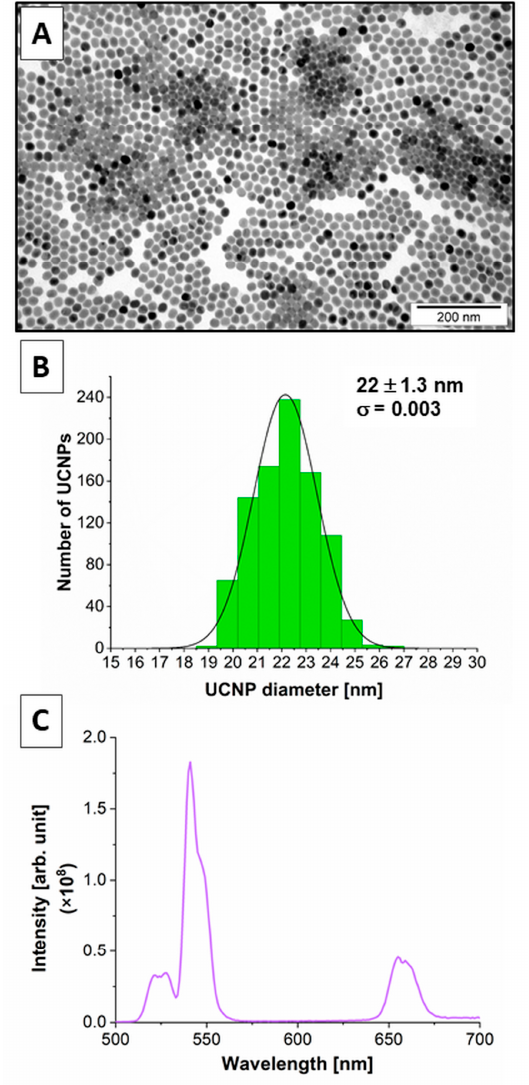
Figure 1. ( A ) TEM and ( B ) Size distribution histogram for β -NaYF 4 :20%Yb 3+ ,2%Er 3+ UCNPs. ( C ) Upconversion luminescence spectra of β -NaYF 4 :20%Yb 3+ ,2%Er 3+ UCNPs solution in cyclohexane at a 1 mg mL − 1 concentration after 980 nm continuous wave laser excitation with a power density of 7.4 W cm − 2 .